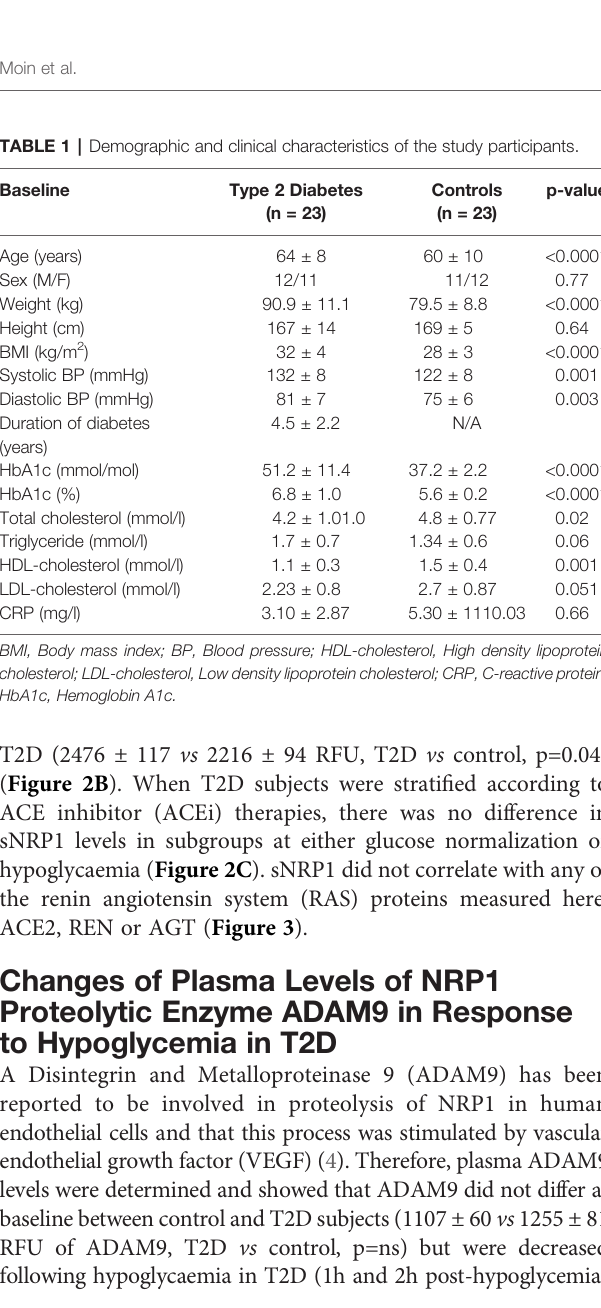
TABLE 1 | Demographic and clinical characteristics of the study participants.